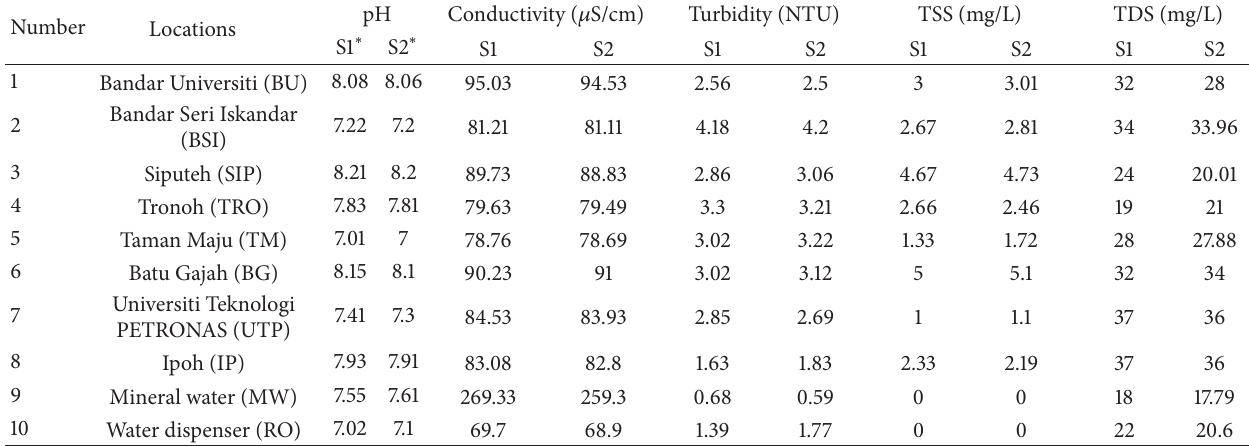
Table 3: Physical-chemical parameters of drinking water samples in Perak state, Malaysia.